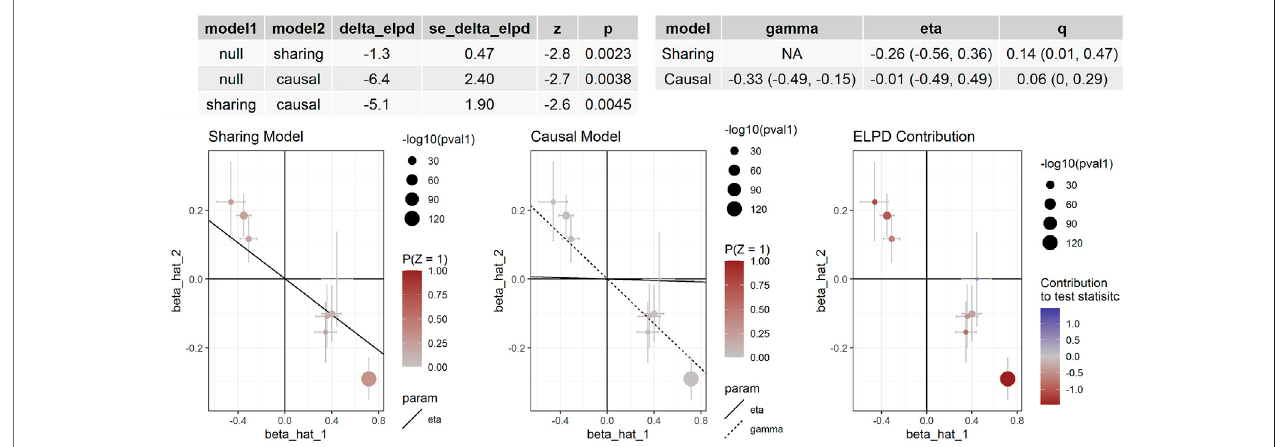
FIGURE 5 | The association between cg04812164 methylation and SBP in Europeans. This fi gure presented the results of the CAUSE analysis for the association betweencg04812164methylationandSBP.Theanalysisshowedthatthecausalmodelwassigni fi cantlybetterthanboththenullandthesharingmodels,indicatingthe causal relationship between cg04812164 and